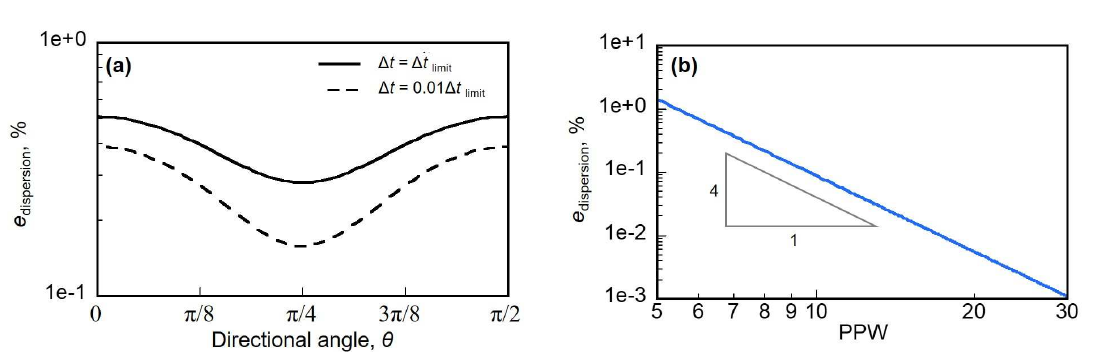
Figure 2. Dispersion characteristics of explicit time domain finite element method (TD-FEM) using modified Adams method: ( a ) anisotropic characteristics in the dispersion error in terms of sound propagation directions with two time interval values of ∆ t = ∆ t limit and ∆ t = 0.01 ∆ t limit and ( b ) convergence of dispersion error relative to spatial resolution points per wavelength (PPW).